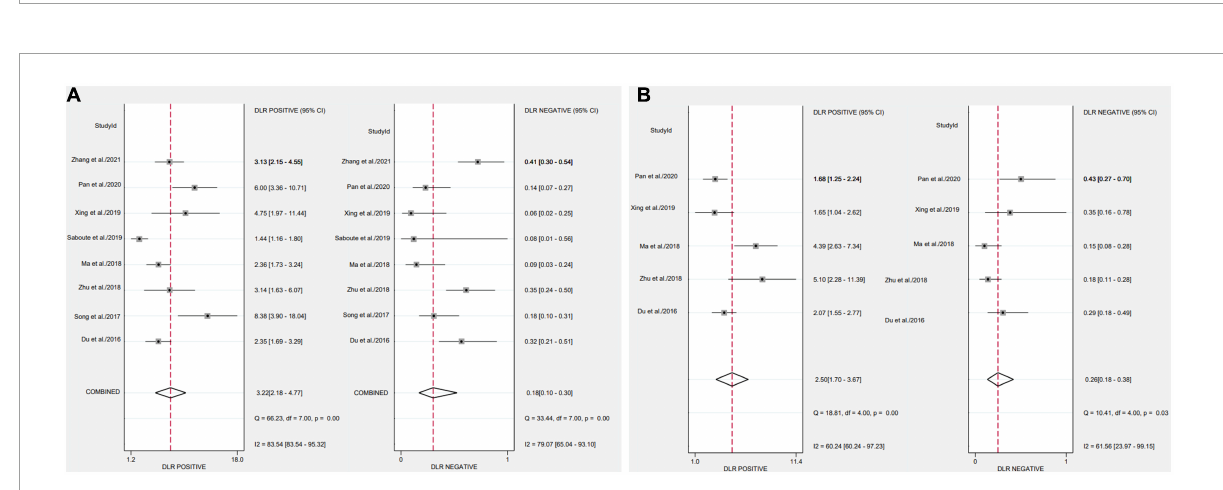
FIGURE5 Forest plots of likelihood ratio of biomarkers aimed at sepsis (A) , interleukin 35 (IL-35) (B) , procalcitonin (PCT).